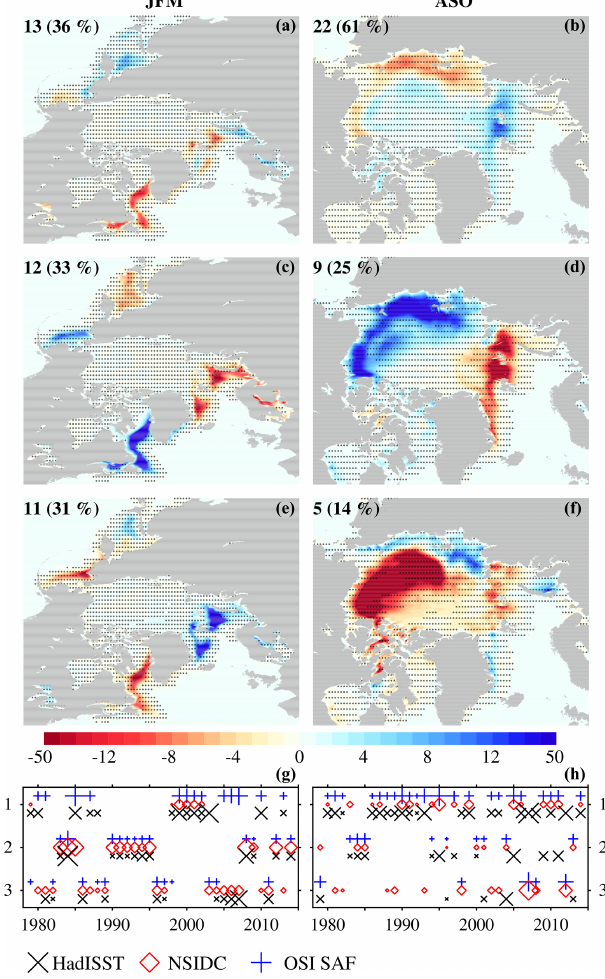
Figure 9. As in Fig. 5 but after detrending with a second-degree